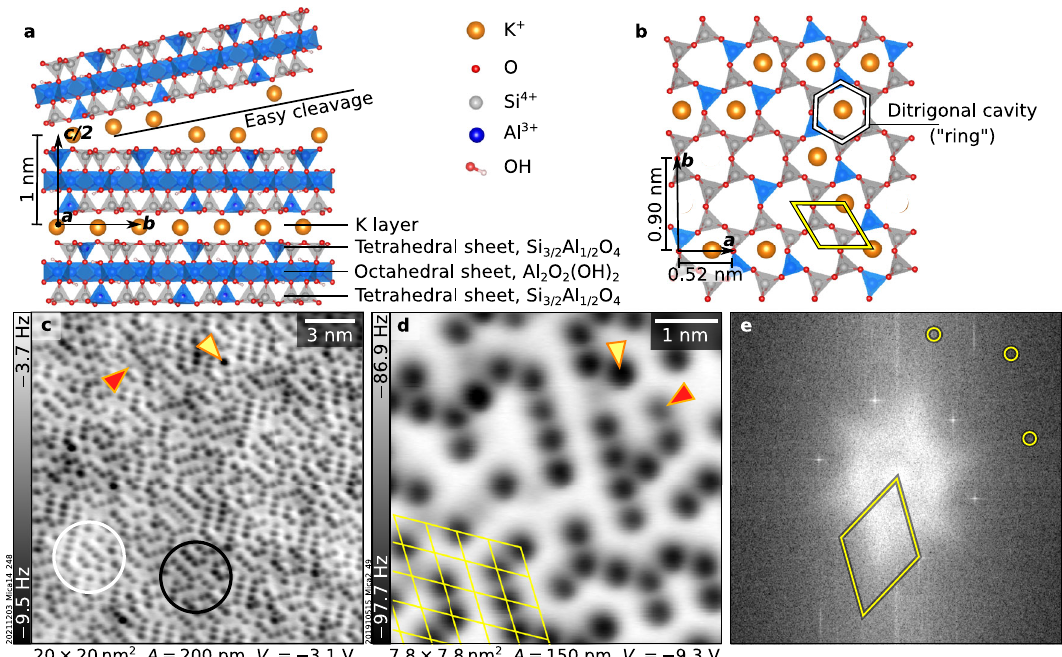
Fig. 1| Cationorderingonas-cleavedmica.a , b Crystalstructureof mica.Alions (blue)inthetetrahedralsheetsareplacedinapseudo-randomarrangementakinto Fig. 4e, showing one possible arrangement fi tting the experimental data. a Side viewofbulkmica.CleavingoccursattheKlayer,leavinghalftheK + cationsoneach side. b Top view of the surface after cleaving. Before cleaving, each ditrigonal cavity (ring, highlightedin white) isoccupied by one K + ion. After cleaving,50% K + ions remain on each cleaved surface. c , d Atomically resolved constant-height nc- AFM imagesof micaafterUHVcleaving,acquired withaCO-functionalizedtipand